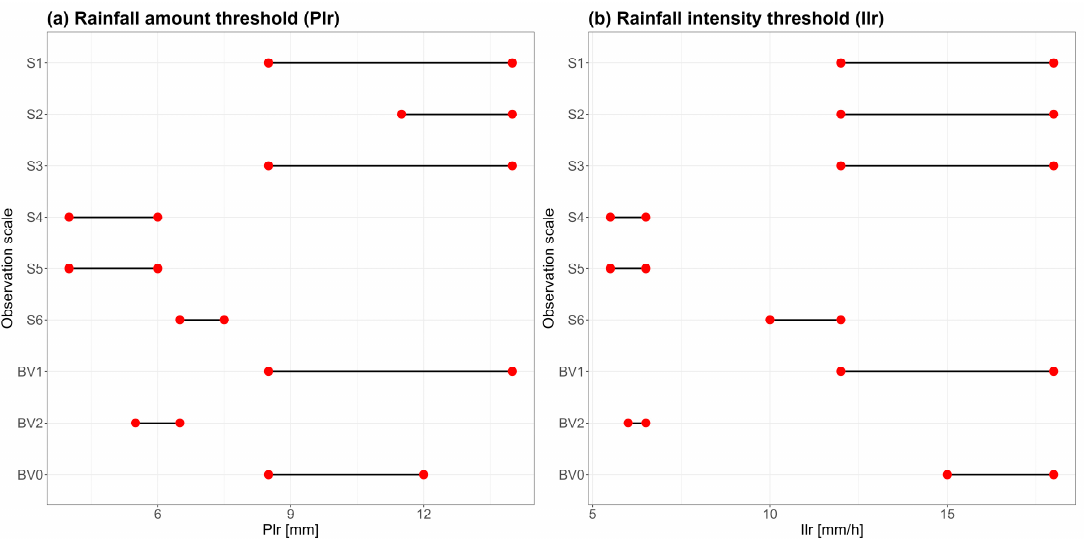
Figure 6. Minimum rainfall amount ( a - Plr ) and intensity ( b - Ilr ) thresholds triggering surface runoff according to plot location and observation scale in the Tougou watershed.